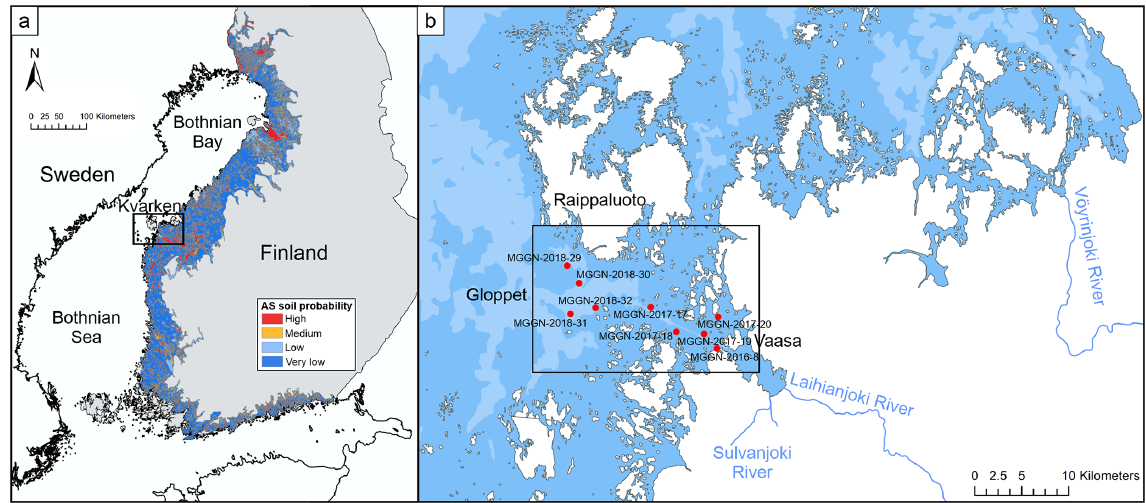
Figure 1. Maps of the Baltic Sea and study area. (a) Map of the Baltic Sea and the probability of acid sulfate soil occurrence in Finland. Black square indicates the location of the study area on the west coast of Finland. (b) Nautical chart of the study area in the Kvarken Archipelago. Red dots indicate the sediment coring sites of this study. Sources: acid sulfate soil probability map – Geological Survey of Finland, 2018; nautical chart – Finnish Transport Agency,